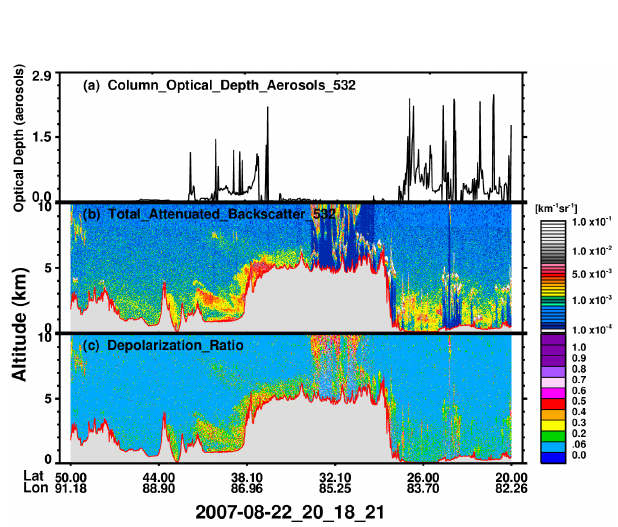
Figure 2. Aerosol optical depth (a) , altitude-orbit cross-sections of the total attenuated backscattering (b) and depolarization ratio (c) on 22 August 2007 along the trajectory of the CALIPSO satellite over the TP, as presented in Fig. 1. The gray shading indicates the